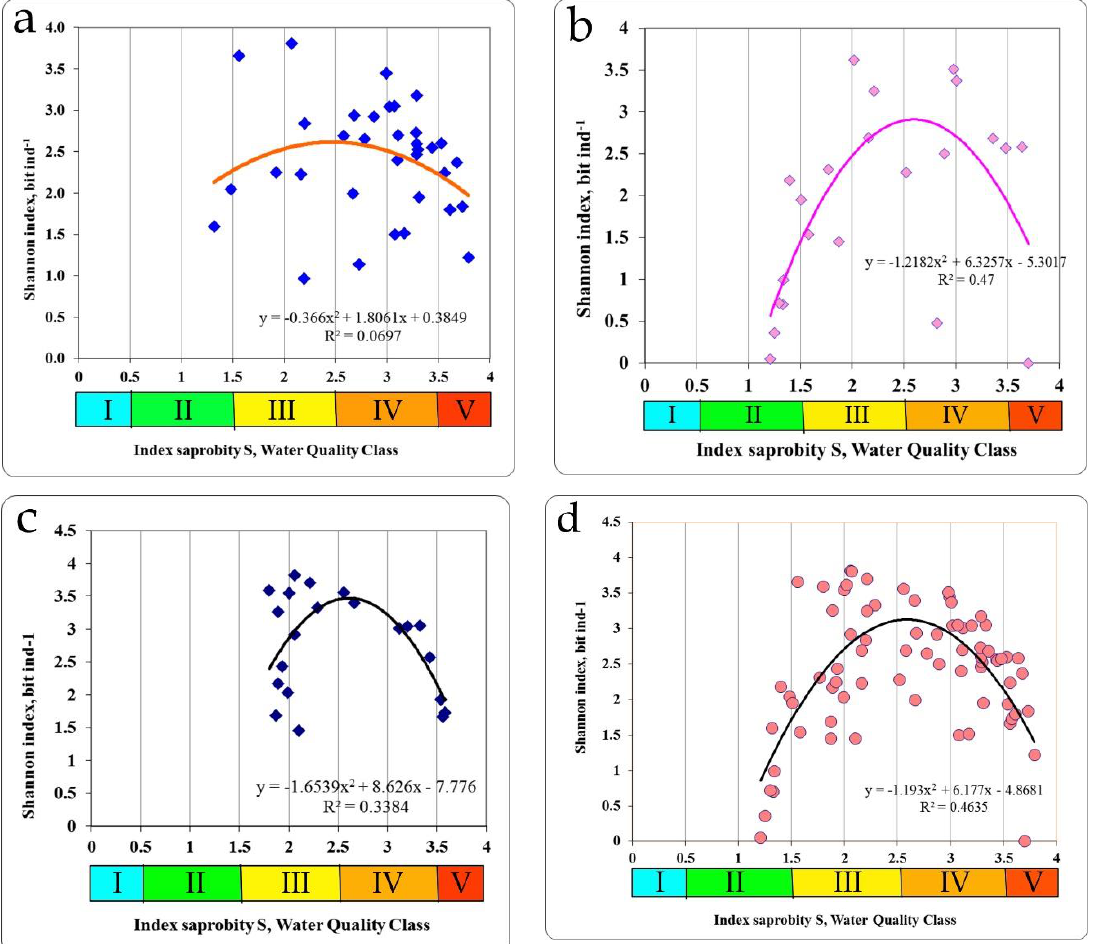
Figure 6. The fluctuation of the index of species diversity of zoobenthos in the gradient of saprobity index S. KhNPP cooling pond, Vilia River, Goryn River ( a ); technical reservoirs of the RNPP, the Styr river ( b ); ChNPP cooling pond, floodplain lakes of the Chernobyl NPP zone ( c ); all data ( d ).